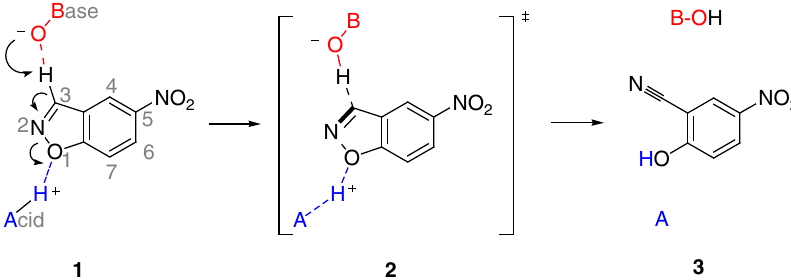
Fig. 1 Reaction scheme for the Kemp elimination of 5-nitrobenzisoxazole. The nucleophilic oxygen atom of the base (B) donates electrons to the electrophilic 3 ′ -H of 5-nitrobenzisoxazole and the electronegative oxygen atom of the isoxazole group forms a hydrogen bond with an acid (A) ( 1 ), forming a transition state in which the C − H and N − O bonds are weakened ( 2 ). The removal of the 3 ′ -H from the substrate leads to an anionic phenoxide intermediate, which is then protonated, forming the fi nal product ( 3